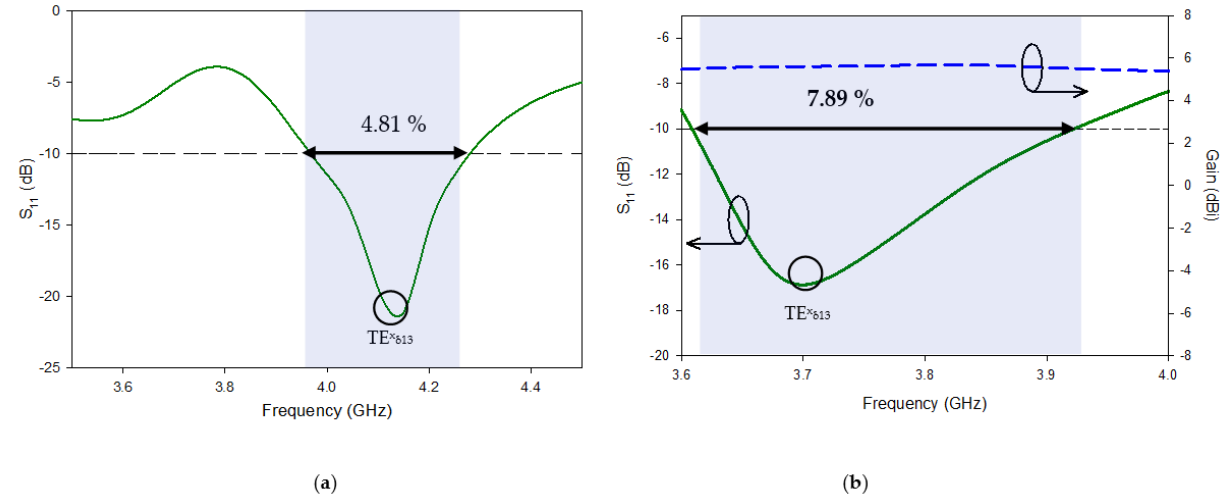
Figure 4. Simulated S 11 and Gain of ( a ) antenna ‐ A and ( b ) antenna ‐ B. Figure 3. Evolution of the RDRA wideband antenna (3-D View) ( a ) Antenna-A, RDRA with the T- shape feed; ( b ) antenna-2, RDRA with a novel flat surface metal strip (Yagi-Uda); ( c ) desired wideband RDRA with the parasitic patch.